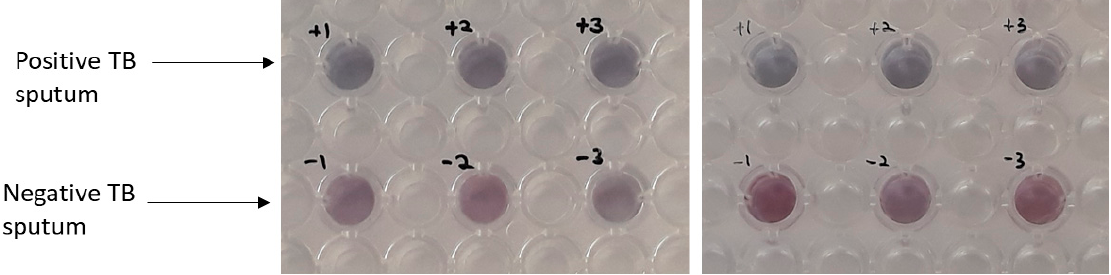
Figure 8. Detection of CFP-10 in sputum samples from positive TB patient and also from negative TB patient as control experiment.